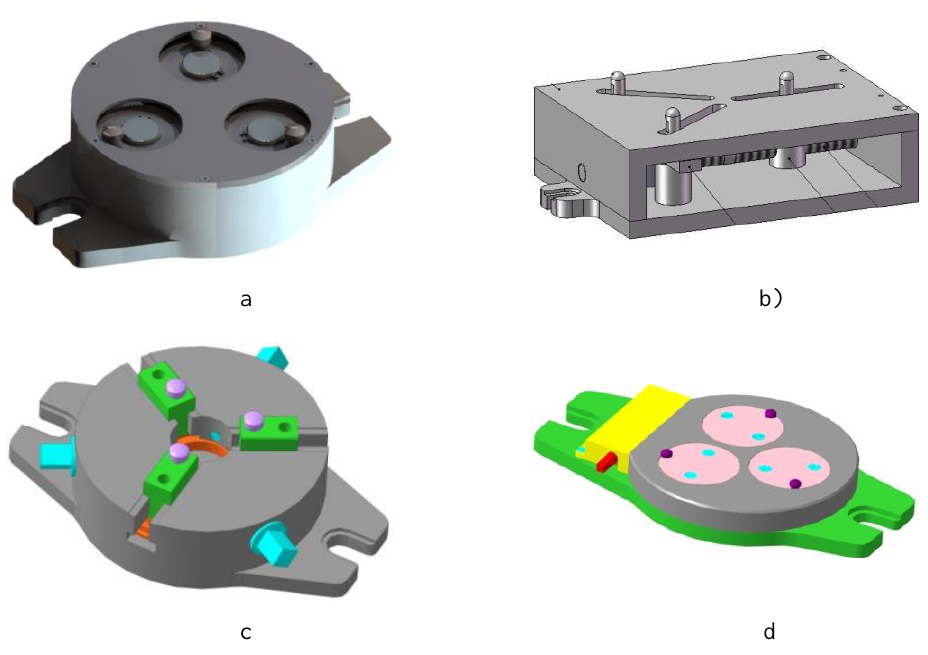
Figure 1. Adjustable locating modules for setup of prismatic parts according to the plane